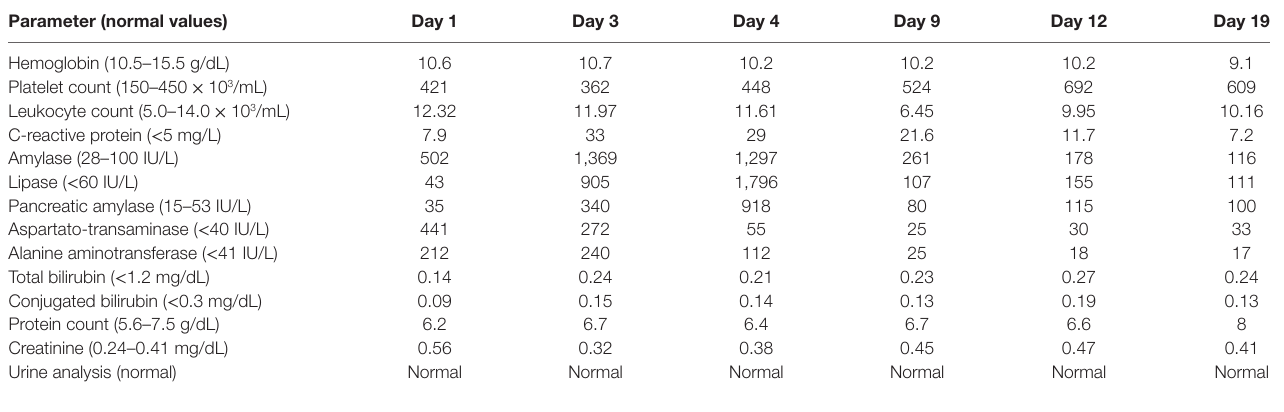
taBLe 1 | Laboratory findings at clinical presentation and during hospitalization. parameter (normal